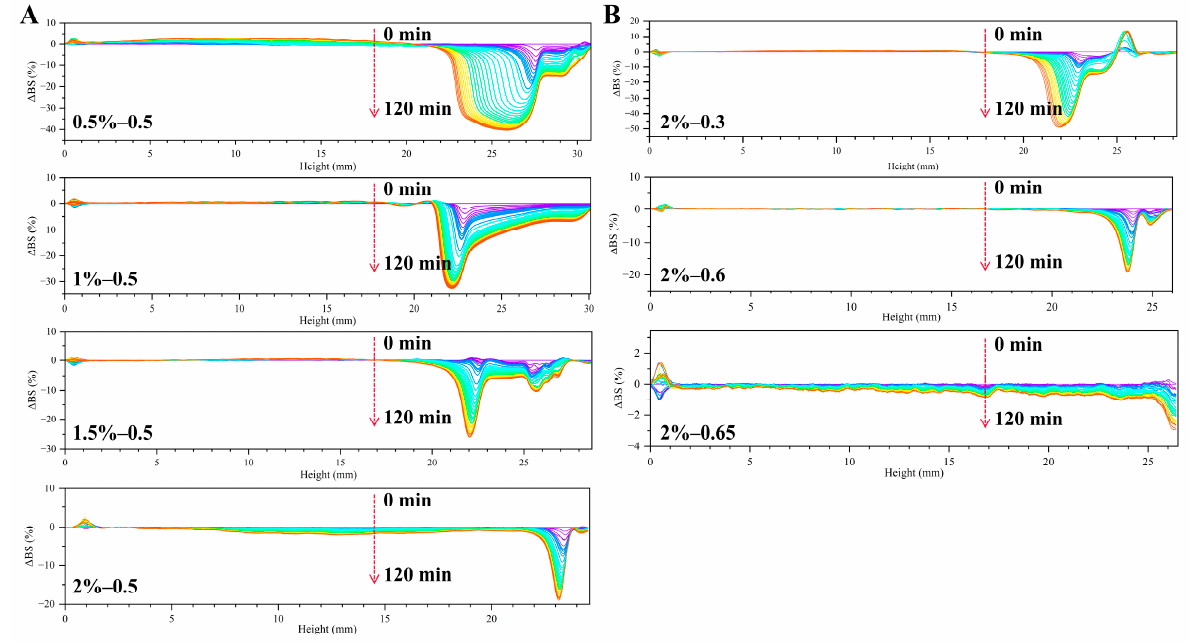
Figure 9. ∆ BS of Pickering emulsions stabilized with different c (0.5–2 wt%) of LF–FD complexes at different ϕ (0.3–0.65): ( A ) ϕ = 0.5; ( B ) c = 2 wt%.